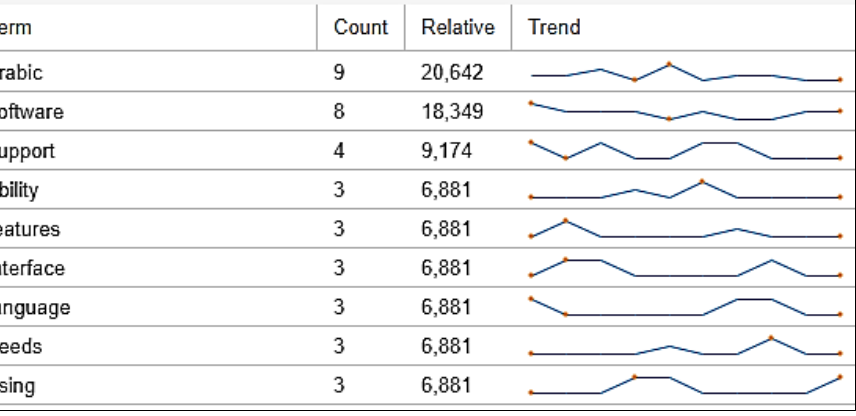
Figure 5. Most frequently used words in participants’ responses who suggested improvements for CAT.